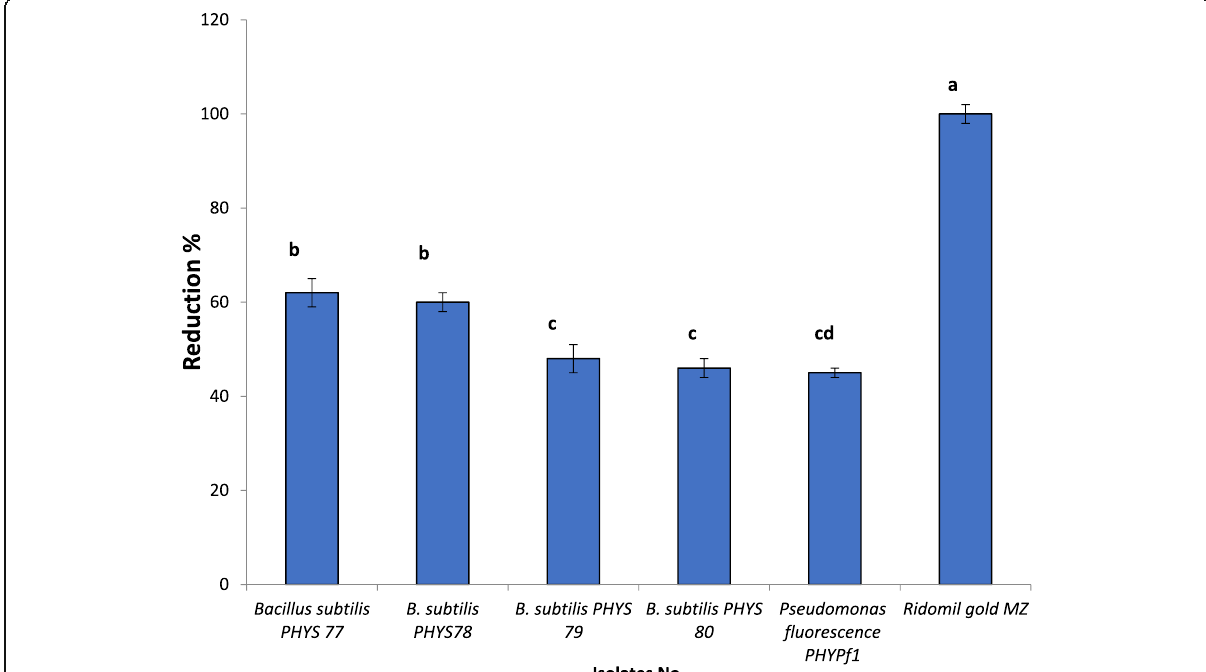
Fig. 4 Evaluation of inhibitory effect of certain bacterial isolates against B. allii PHYOA1 in vitro . Values on the column followed by a similar letter are not significantly different as determined by the LSD test ( P < 0.05)